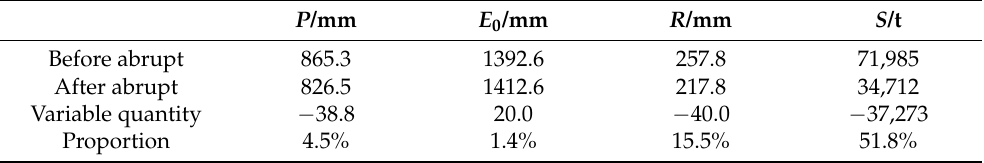
Table 2. Hydrological and meteorological trends before and after abrupt change.